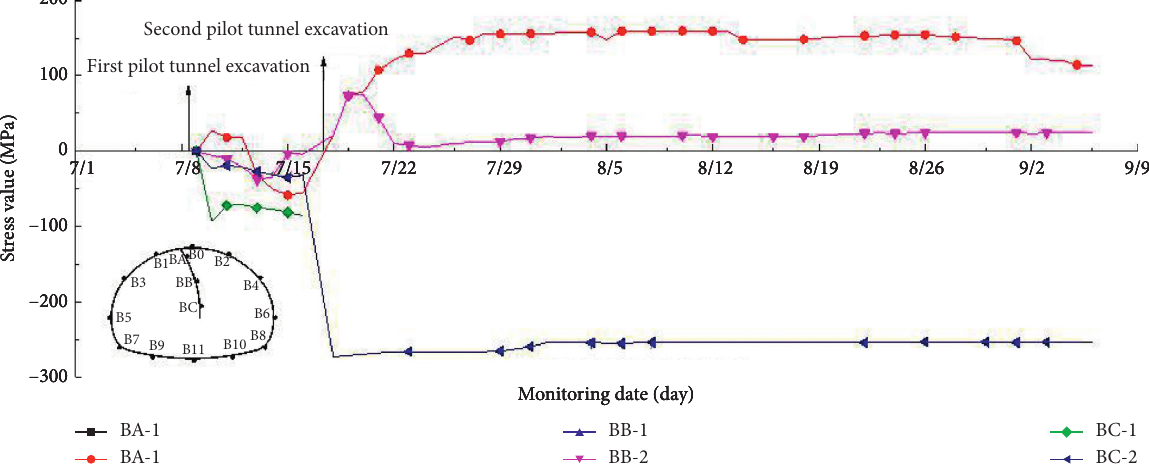
Figure 16: Stress time curve of temporary support steel rib in YK2+133